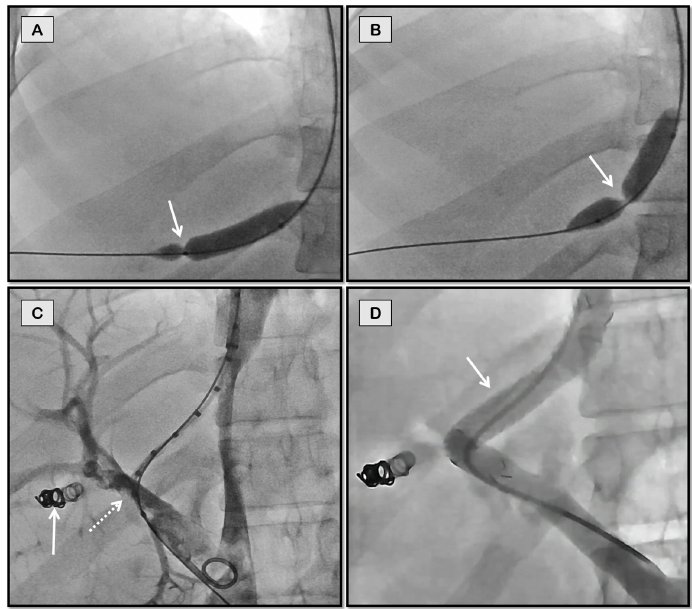
Figure 4. Percutaneous transhepatic access for portosystemic shunting in a 26-year-old man with chronic hepatic and portal vein thrombosis with refractory ascites. Fluoroscopic spot images ( A , B ) show through-and-through access obtained between percutaneous transhepatic and jugular punc- ture sites with a balloon inflated to demonstrate the portal puncture site (arrow in A ) and IVC punc- ture site (arrow in B ). Post balloon maceration and thromboaspiration ( C ), there is partial recanali- zation of the portal vein (dashed arrow). Coils used to close the percutaneous tract can also be seen in this image (solid arrow). Good flow across the stent was noted on the completion angiogram (arrow in D ). The tract between the portal vein and IVC is then balloon dilated, and the portal vein is accessed from the jugular approach to stent deployment. The advantage of the transhepatic approach is that accessing the portal system via this shorter route through the liver under image guidance is considered relatively easier compared to the longer transjugular route wherein a longer needle has to be manipulated through the metallic cannula. However, concern for access site complications remains, especially in patients with coagulopathy and ascites. With the advent of intravascular ultrasound and the trans- splenic approach, the transhepatic route is less commonly utilized. 4.3. Trans-Splenic Approach A significant proportion of patients with portal cavernoma do not have a visible na- tive portal vein on imaging. Thus, alternative routes had to be devised for the placement of TIPS. The trans-splenic approach remains the mainstay for such patients. Originally described in the late 1980s, the trans-splenic route was traditionally associated with high rates of hemorrhagic complications [18]. However, with improved imaging and real-time ultrasound guidance, complication rates directly attributable to the splenic puncture be- came low [19]. The trans-splenic route is considered ideal when there is a large patent splenic vein with one of its branches entering the splenic parenchyma in a direct anatomic or straight line [20]. This intraparenchymal branch is punctured under ultrasound